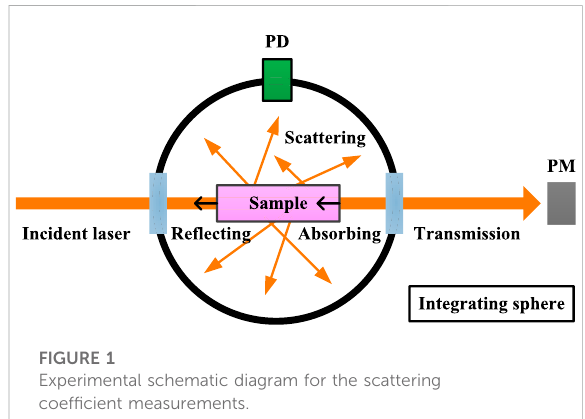
FIGURE 1 Experimental schematic diagram for the scattering coef fi cient